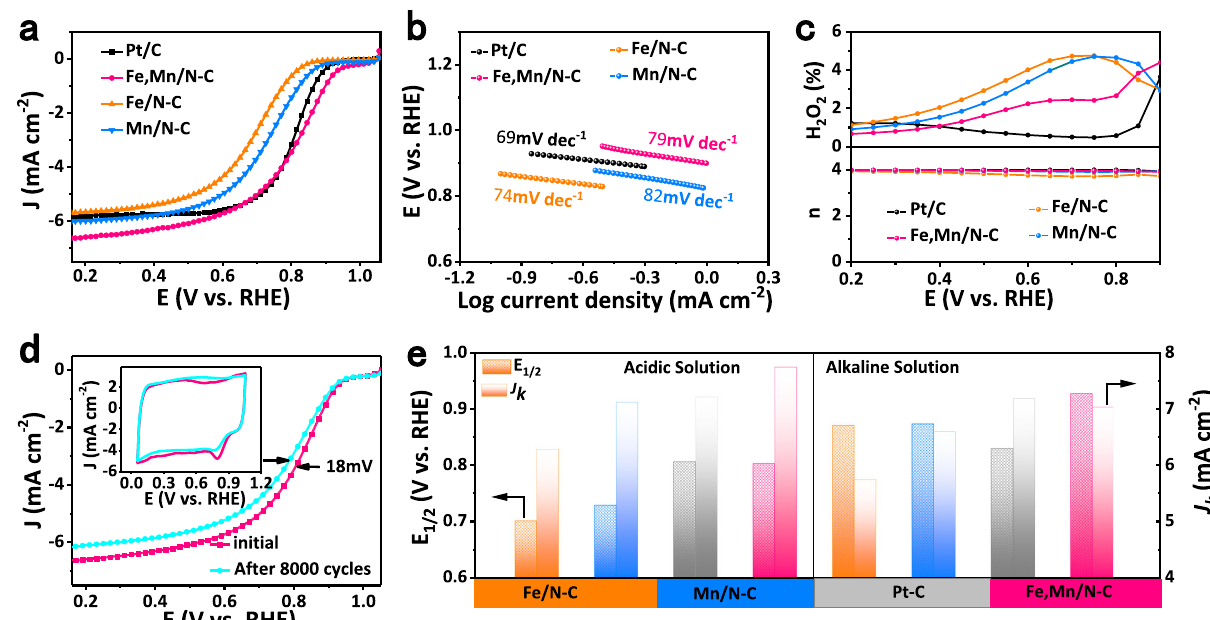
Fig. 3 ORR performances of Fe,Mn/N – C in 0.1 M HClO4 and 0.1 M KOH. a LSV curves of Fe,Mn/N – C, Fe/N – C, Mn/N – C and Pt/C catalyst in O 2 - saturated 0.1 M HClO 4 solution. b Corresponding Tafel plots obtained from the RDE polarization curves. c H 2 O 2 yield and electron transfer number ( n ) in 0.1 M HClO 4 solution. d ORR polarization LSV and CV curves of Fe,Mn/N – C measurement before and after 8000 potential cycles at the scan rate of 50 mV s − 1 with the rotation speed of 1600 rpm. e Comparison of the kinetic current density ( J k ) and E 1/2 of Fe,Mn/N – C, Fe/N – C, Mn/N – C, and Pt/C